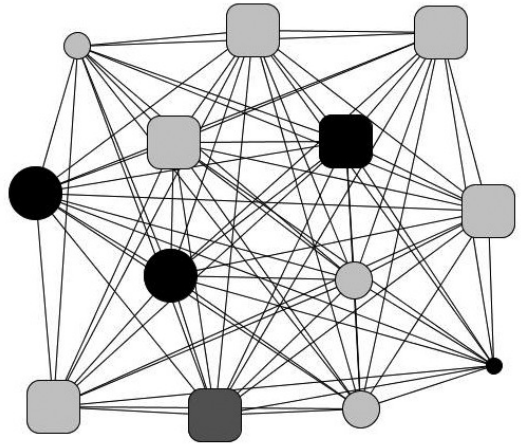
Figure 2. Amparo’s personal network. Notes: Node size indicates relational role—size 1 (biggest; closest family: parents, brothers/sisters, and sons/daughters), size 2 (in‐laws), size 3 (friends, neighbours), size 4 (distant relatives), size 5 (small‐ est; social worker, “others”); node shape indicates gender—circle (female), rounded‐square (male); node colour indicates proximity: black (“very close”), dark grey (“close”), light grey (“not very close”), white (“not close at all”).